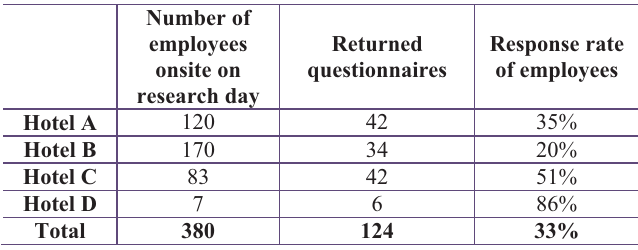
Table 1: Response rate of hotel employees